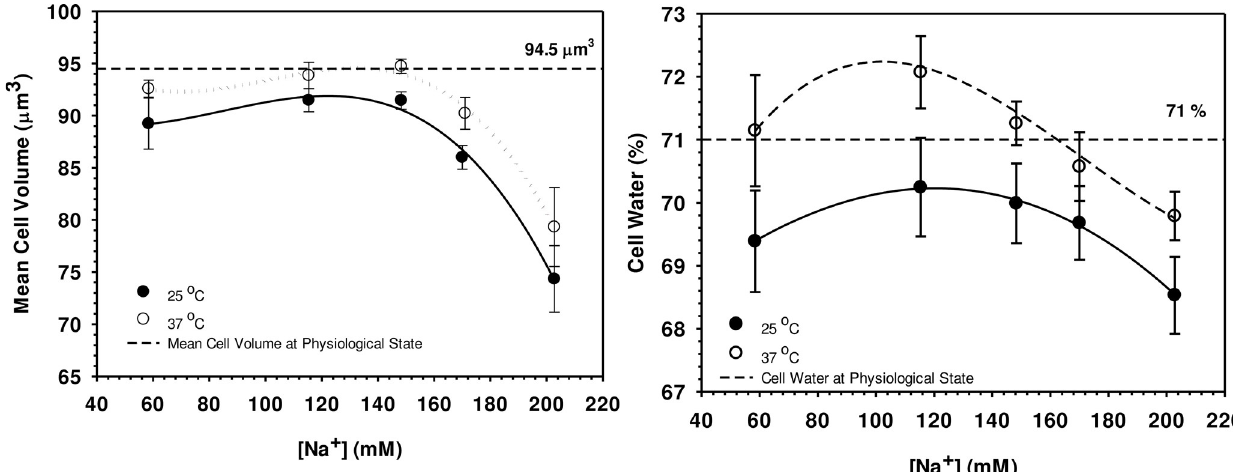
Fig 2. Measured mean cell volume (A) and relative cell water content (B) of HRBC cells suspended in 5 different [NaCl] at 25 and 37˚C compared to that of the physiological cell volume value of 94.5 μ m 3 (the reference lines on the graphs). Error bars are ± SE, means based on 5 replicates (5 separate individuals): fitted lines are spine curves [35]. The Tukey test interval for testing for significant (p < 0.05) differences between any two mean cell volume values (Fig 2A) was V c = 9.50 μ m 3 : V c at the two temperature were not significantly different but at [Na + ] above the control concentration (148 mM) there was significant decreases in cell volume. The Tukey test critical value for cell water (Fig 2B) was 3.04%. Generally cell water was higher at 37˚C but was only significantly higher at lower [Na + ] (58 and 115